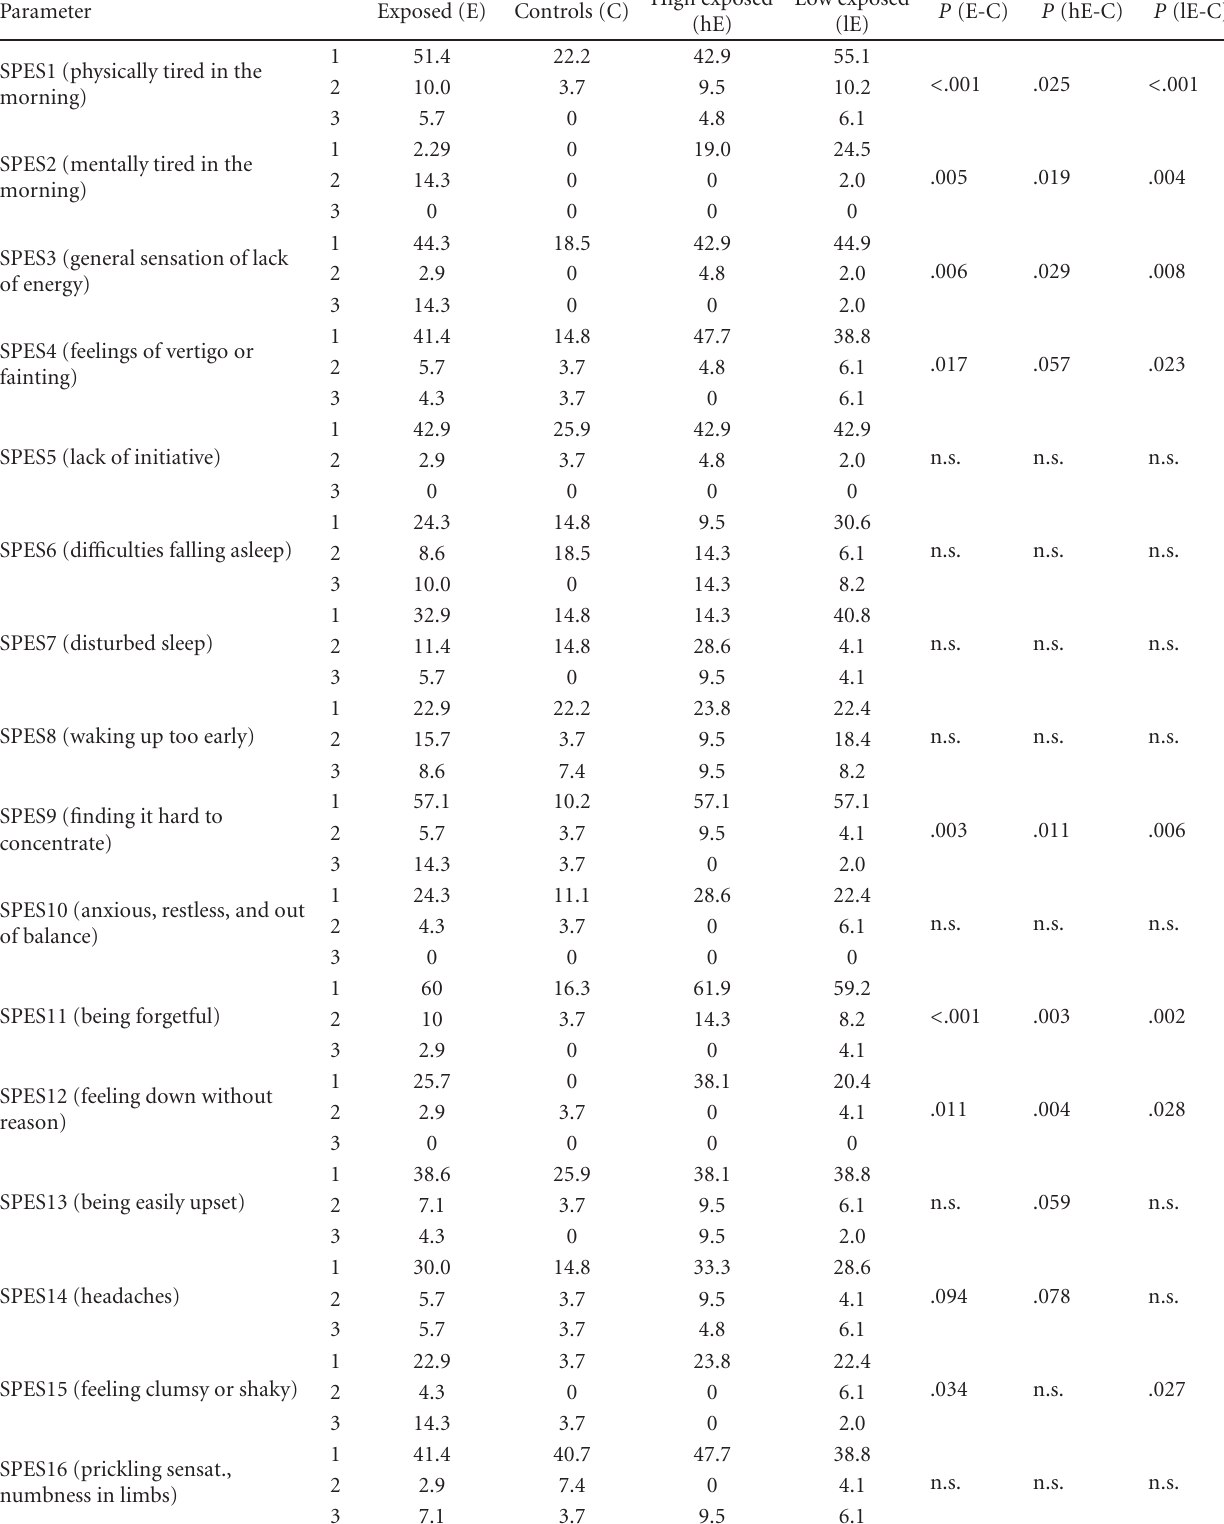
Table 3: Results of the survey (using the SPES method) of complaints experienced by lead-exposed subjects (E) involving the subgroups of highexposed (hE) and lowexposed (lE), and controls (C) during the past six months. In the 16 answers: 1 denoted “occasional”, 2 “often”, and 3 “very often ” (The answers of 1, 2, and 3 to the particular question were percentages within a group; the balance of 100% did not complain of such